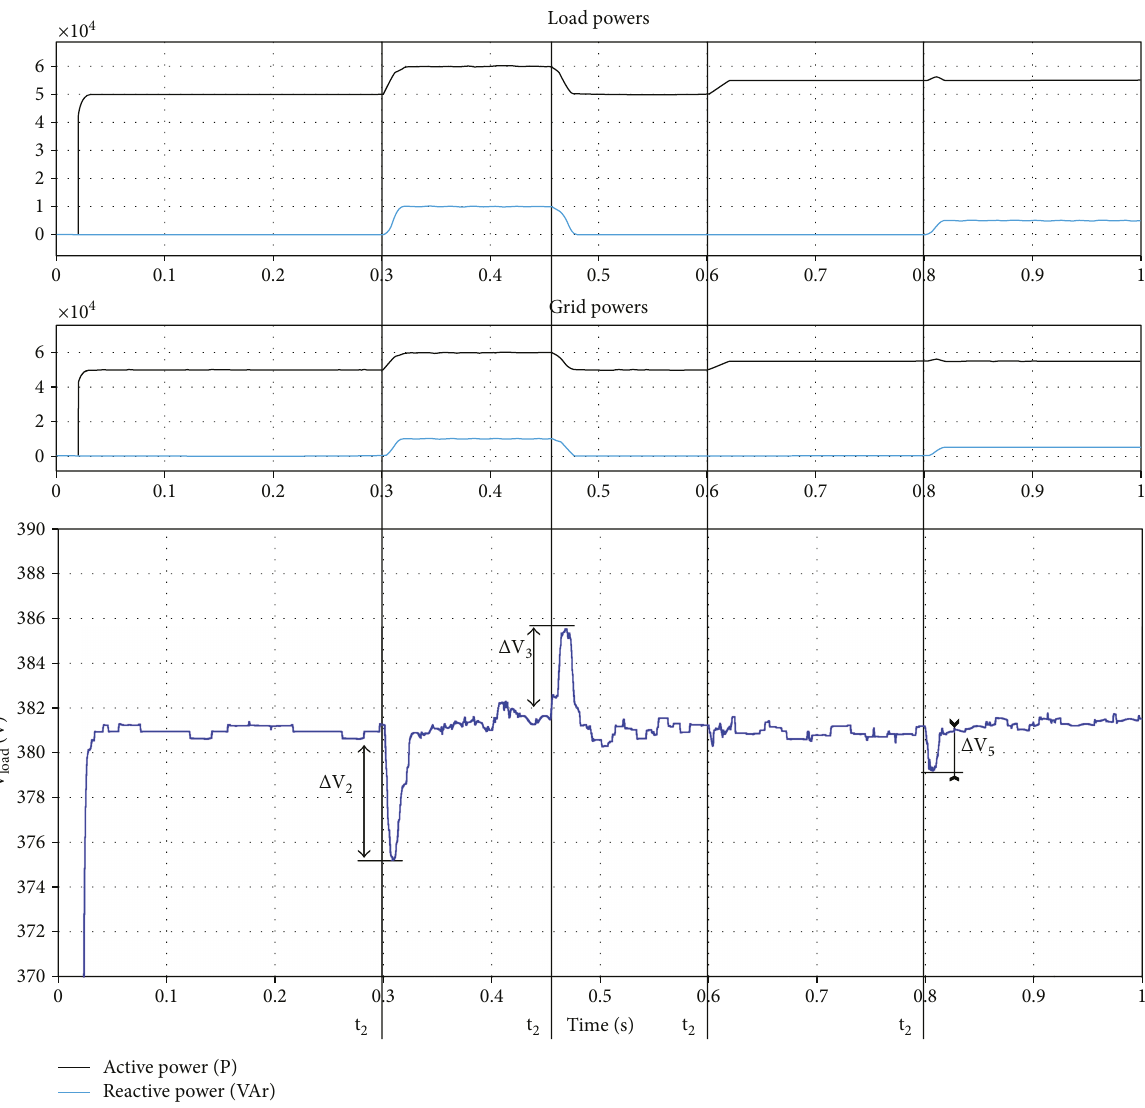
Figure 9: Active, reactive power, and load voltage states on the